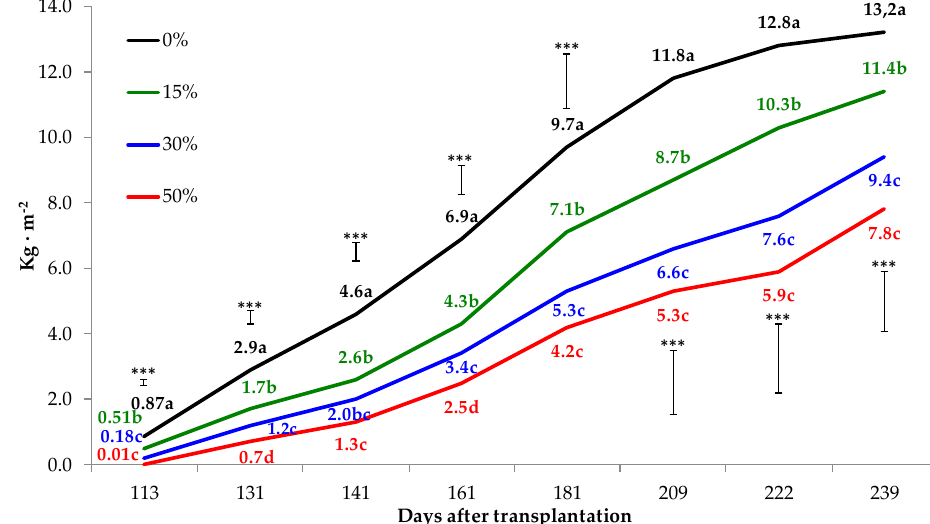
Figure 12. Shading effects on the temporal evolution of accumulated marketable yield (kg · m − 2 ). Results comes from the analysis of the variance that is performed according to the Yij model = μ + α i + β j + ε ij. The nomenclature n.s., *, ** and *** indicates not significant or significant for p ≤ 0.05, 0.01 and 0.001, respectively. Numerical values for each column followed by different letters denote statistical significance for p <0.05 according to the corrected minimum significant differences (LSD) test. The error bars correspond to the values of minimum significant differences according to the corrected LSD test. The nomenclature n.s., *, ** and *** indicates not significant or significant for p ≤ 0.05, 0.01 and 0.001,